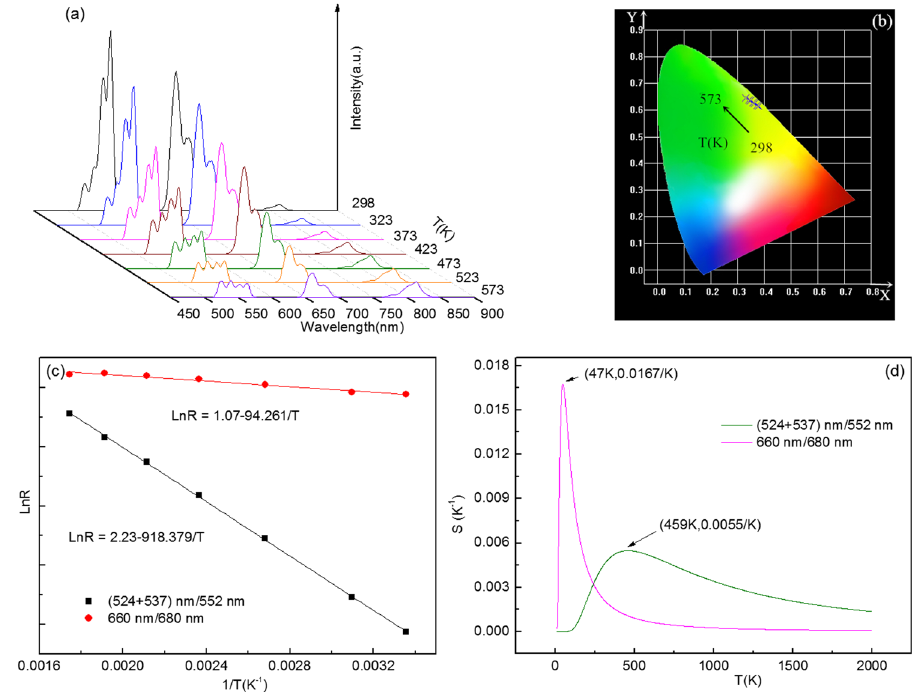
Figure 5. Temperature dependent ( a ) emission spectra, ( b ) CIE (X, Y) chromaticity coordinates diagram, ( c ) Arrhenius plots of emission intensity ratios, and ( d ) sensitivity of Y 2 O 3 :1%Er 3 + , 0.2%Tm 3 + at 184 mW/mm 2